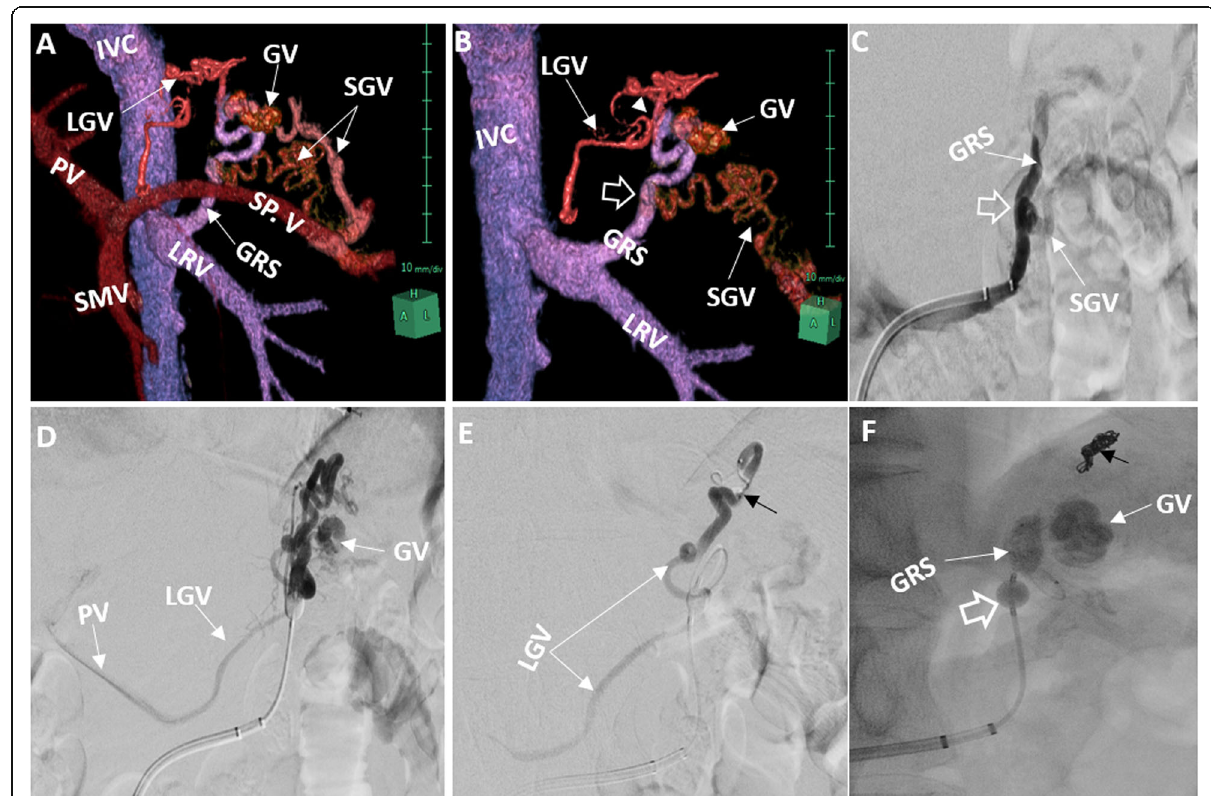
Fig. 3 Selective BRTO technique. a Oblique volume rendering (VR) image obtained from pre-BRTO CE-CT portal phase images shows gastric varices (GV) supplied from short gastric vein (SGV) and drained by gastrorenal shunt (GRS). b The same oblique VR image in a but after subtraction of the feeding SGV, splenic vein (Sp.V), and portal vein (PV) to clearly visualize the direct connection between the other SGV and the proximal part of GRS (hollow white arrow) and the direct connection between left gastric vein (LGV) and the distal part of GRS very near to GV (arrowhead). c D SA image during retrograde venography of the GRS shows the connection between SGV and the proximal GRS (hollow white arrow). d DSA during balloon occluded retrograde venography of GRS shows partial visualization of GV with contrast reflux through the direct connection of LGV with the distal GRS (EAEDC) toward portal vein (PV). e Selective venography within the LGV EAEDC after successful catheterization of the EAEDC using microcatheter (black arrow) for EAEDC coiling to prevent EOI reflux into the PV. f Fluoroscopic image at the end of BRTO shows balloon catheter (hollow white arrow) positioned at the middle part of the GRS above the level of SGV EAEDC while LGV EAEDC was coiled (black arrow) with total opacification of the distal part of GRS and GV with